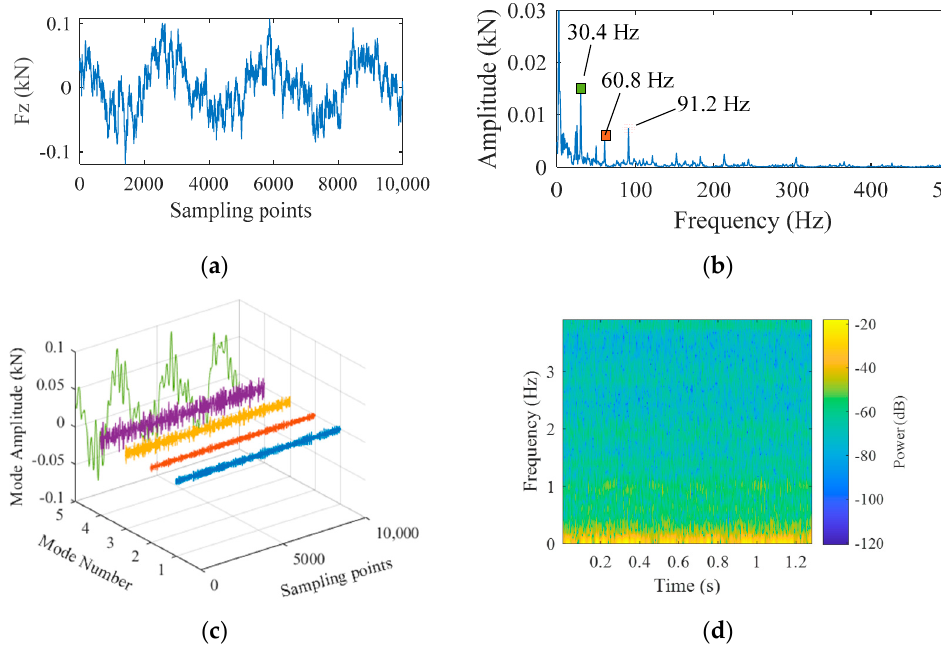
Figure 4. Analysis of noise signals: ( a ) noise signals collected before welding; ( b ) amplitude spectrum; ( c ) VMD results; ( d ) power spectrum of noise